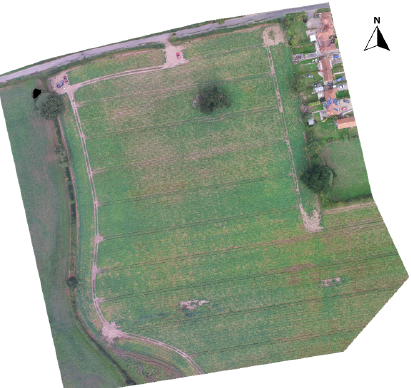
Figure 4. Data collection site at Claxton, York, United